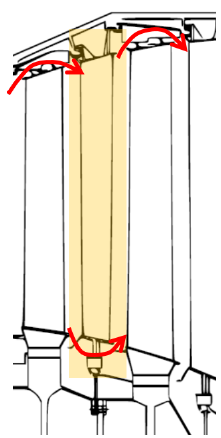
Figure 11. Cavity purge